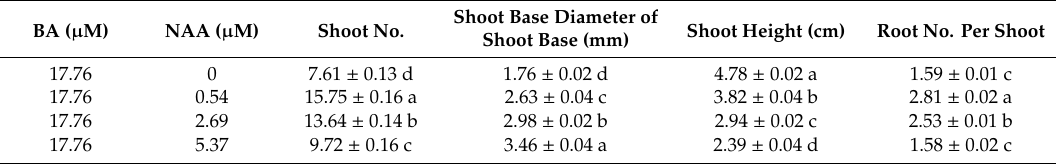
Table 4. Induction of adventitious shoots from PLBs after six weeks of culture of a piece of clump on Murashige and Skoog medium supplemented with BA and